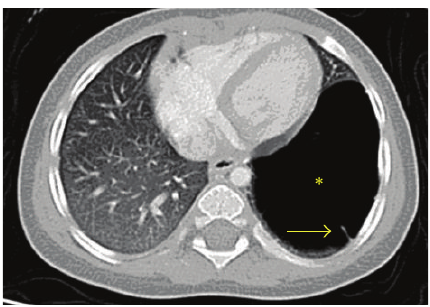
Figure 3: Transverse US image demonstrates a small bowel intus- susceptions in the left lower quadrant containing an echogenic leading point (arrow) corresponding to the leading